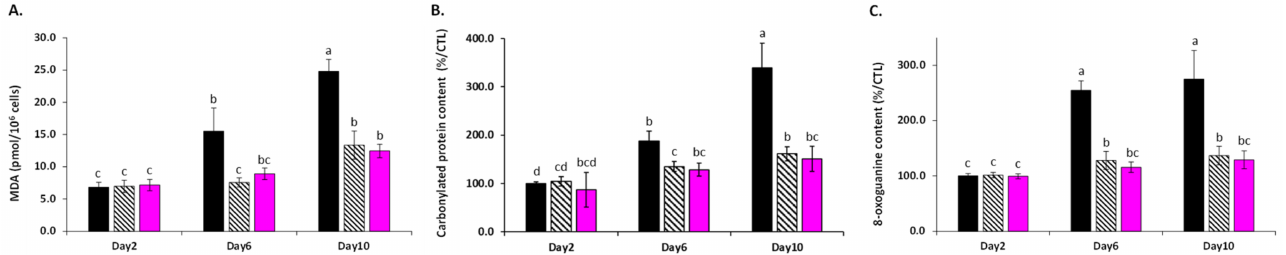
Figure 4. Production of: ( A ) malondialdehyde (MDA, indicators of membrane lipid peroxidation) concentrations determined by the TBARS assay; ( B ) protein carbonyl contents determined by ELISA assay (as a biomarker of oxidative damages on proteins); ( C ) 8-oxo-guanine content determined by ELISA assay (as an indicator of oxidative damages at DNA level). LSE: sacred lotus stamen extract (0.5 mg/mL); RES: E-resveratrol (10 µ M) used as positive antiaging control. Significant differences ( p < 0.05) are shown by different